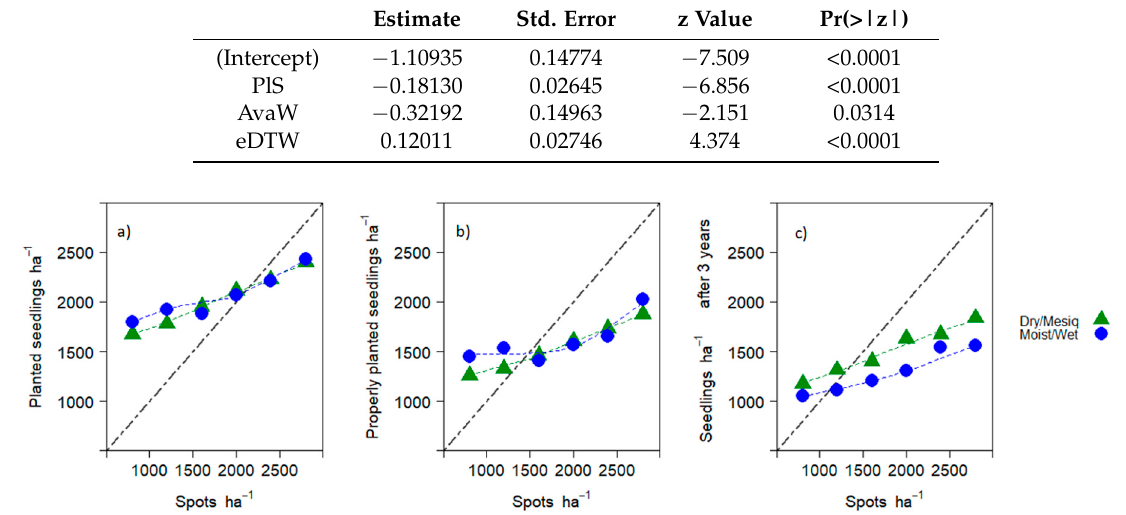
Figure 5. Densities of ( a ) all planted seedlings and ( b ) properly planted seedlings in the planting year, and ( c ) number of surviving planted seedlings three years after planting, in sample plots of indicated soil moisture classes derived from DTW raster values. The x -axes represent the number of suitable planting spots ha − 1 in corresponding sample plots.